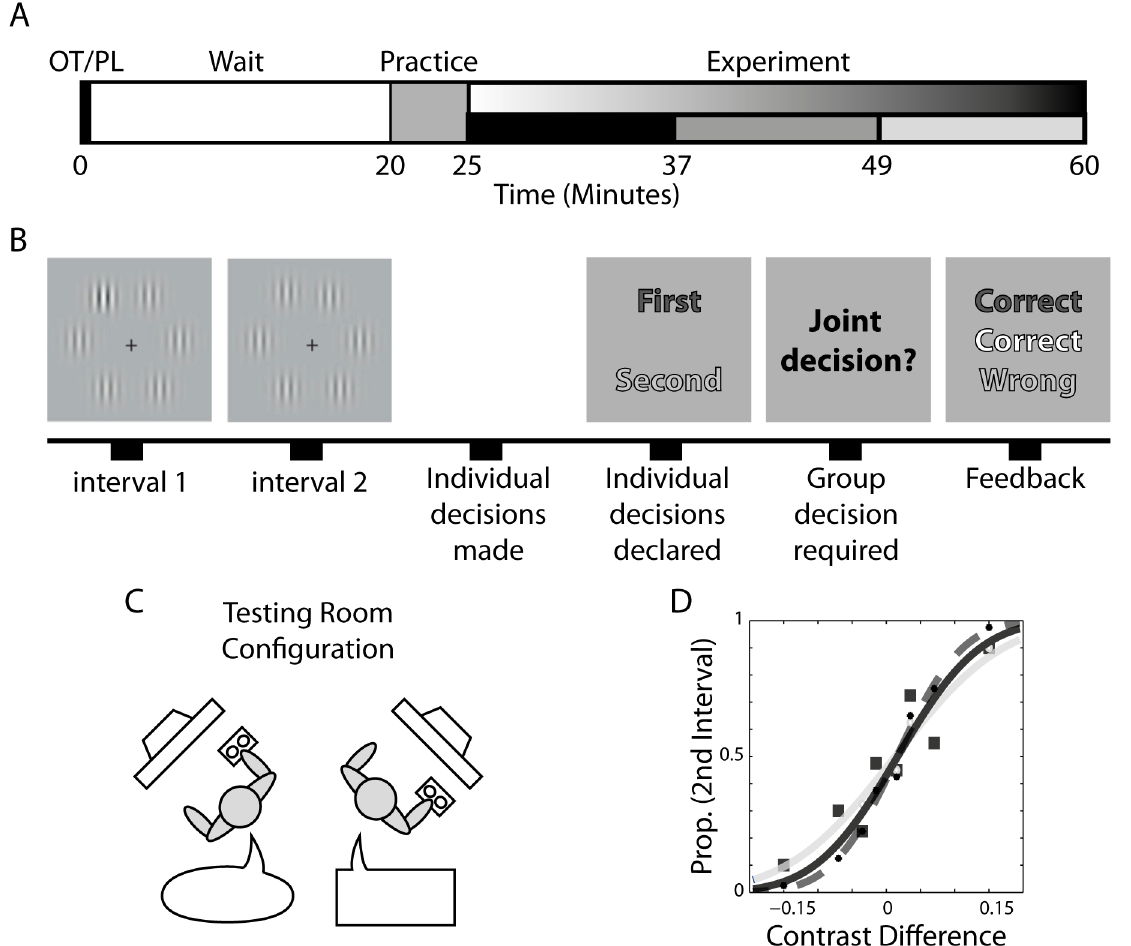
Fig 2. Experimental and task design. (A) Experimental timeline. The experiment started with intranasal self-administration of oxytocin or placebo (double blind). Participants waited quietly for 20 minutes and the performed a 5-minute practice block. The experiment proper started 25 minutes after administration. The experiment duration varied but lasted at least 35 minutes in all dyads, by which time the average of 224 were carried. (B) Pairs of male participants (dyads) performed together a 2-alternative forced choice oddball detection task. Visual stimuli consisted of six vertically oriented Gabor patches displayed equidistantly around an imaginary circle. One randomly selected interval contained the target of higher contrast. Participants indicated their individual decisions privately. If they disagreed, a joint decision was negotiated and announced. Feedback about accuracy was provided. (C) Participants sat in the same testing room, each viewing his own display. Display screens were placed on separate tables at a right angle to each other. (D) We measured the proportion of trials on which the observer reported that the target was presented in the second interval in different target contrast levels, and fitted a psychometric curve to these data. For each dyad three curves were fitted: two for the individual decisions made by each dyad member, and one for the dyadic decisions. Here we depict the psychometric curves fitted to one exemplar dyad. We present the better member data (dark square) and fitted curve (dark line), worse member data and fitted curve (light line and light circles), and dyadic data and fitted curve (dark dots and dashed line). In this case dyadic slope is steeper than the best member ’ s slope, indicating positive collective